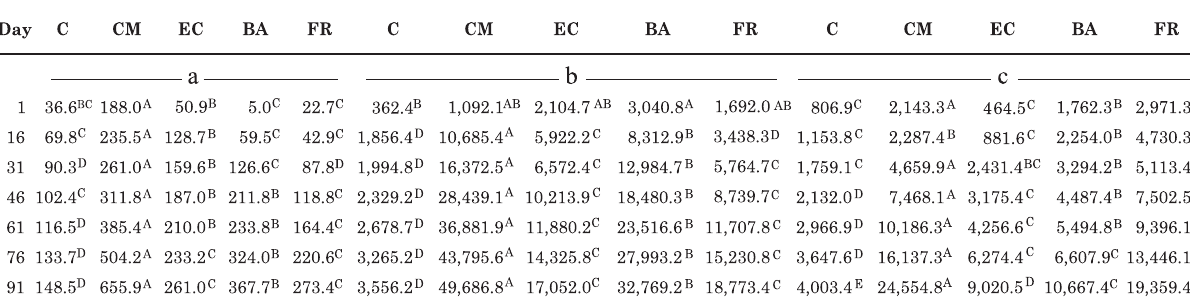
Table 2. Sum of cellulase ( ∑∑∑∑∑ μμμμμ g glucose g -1 soil 24 h -1 ) (a), protease ( ∑∑∑∑∑ μμμμμ g Tyr g -1 soil 2 h -1 ) (b) and